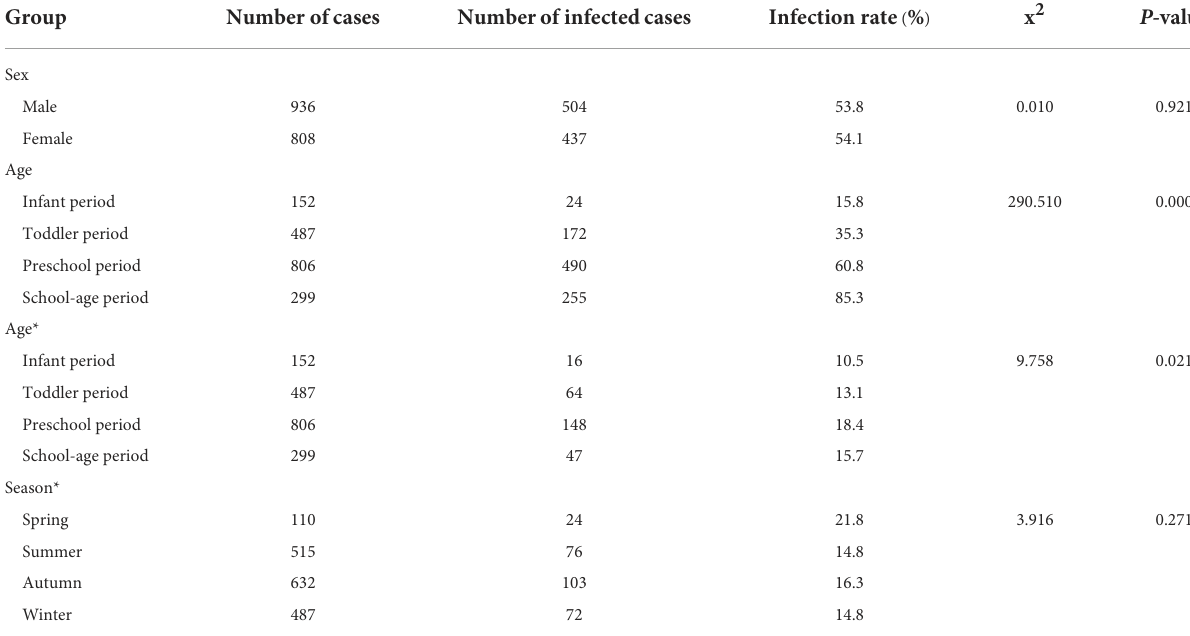
TABLE 2 Comparison of the EBV infection rate by sex, age, and seasonality. Group Number of